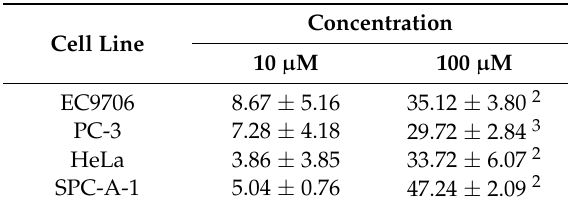
Table 14. Cancer cell 72 h inhibition rate by 72 1 .